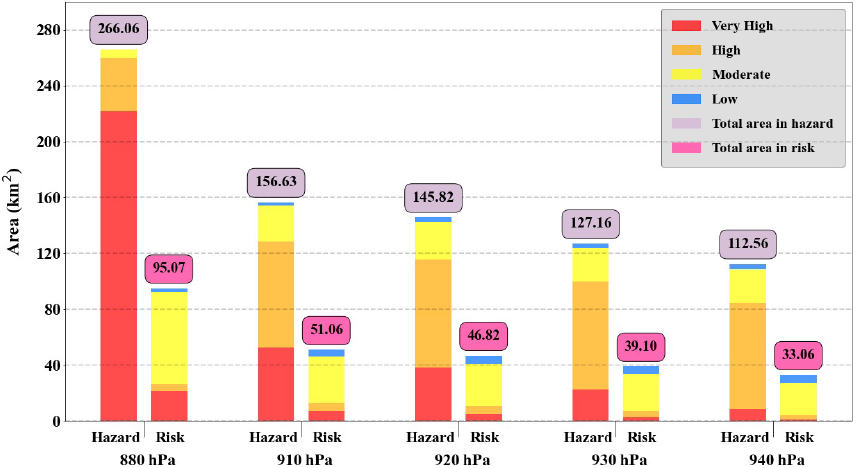
Figure 21. The total area of hazard and risk of storm surge for each of the designed typhoon scenarios (880, 910, 920, 930, and 940hPa).